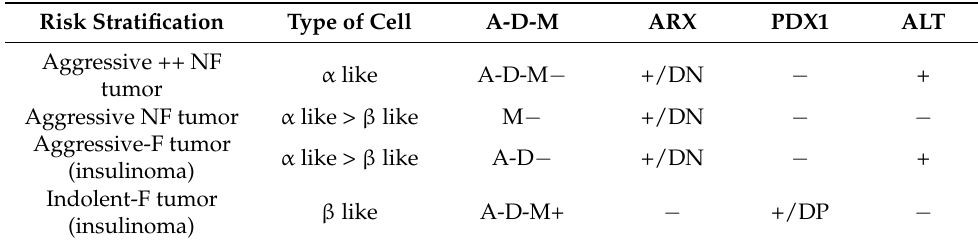
Table 3. Routine tool in Pancreatic neuroendocrine tumors for risk stratification based on IHC and FISH analysis 1